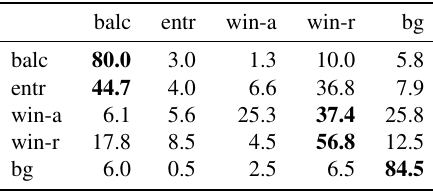
Table 4: Confusion matrix just using aggregates of A 5 , accuracy 63 . 6 , see Table 1